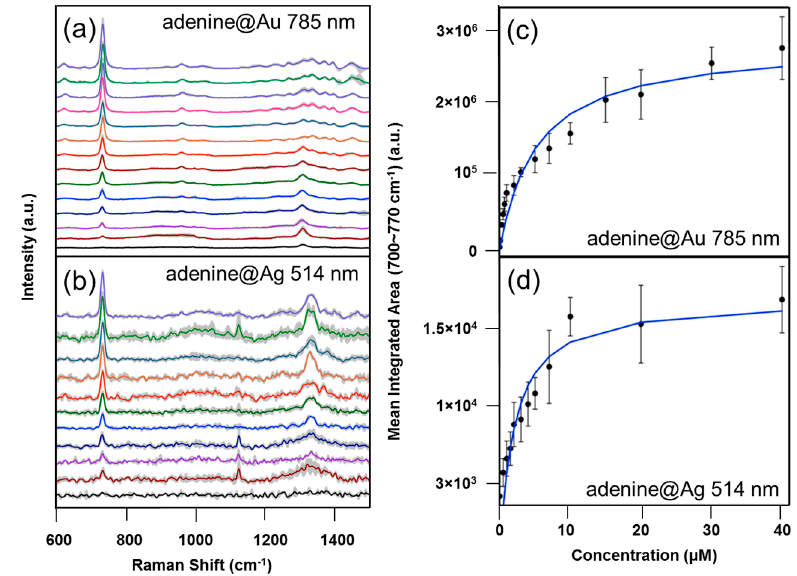
Figure 5. ( Left ) Average SERS spectra (±1 intensity standard deviation as grey shaded areas) at several concentrations of adenine on ( a ) Au substrates, at 785 nm and on ( b ) Ag substrates at 514.5 nm excitation. ( Right ) Adsorption curves of ( c ) adenine on Au and ( d ) on Ag, fitted with Langmuir isotherms (error bars represent ±1 standard deviation over spectra collected from seven different random locations on a substrate).